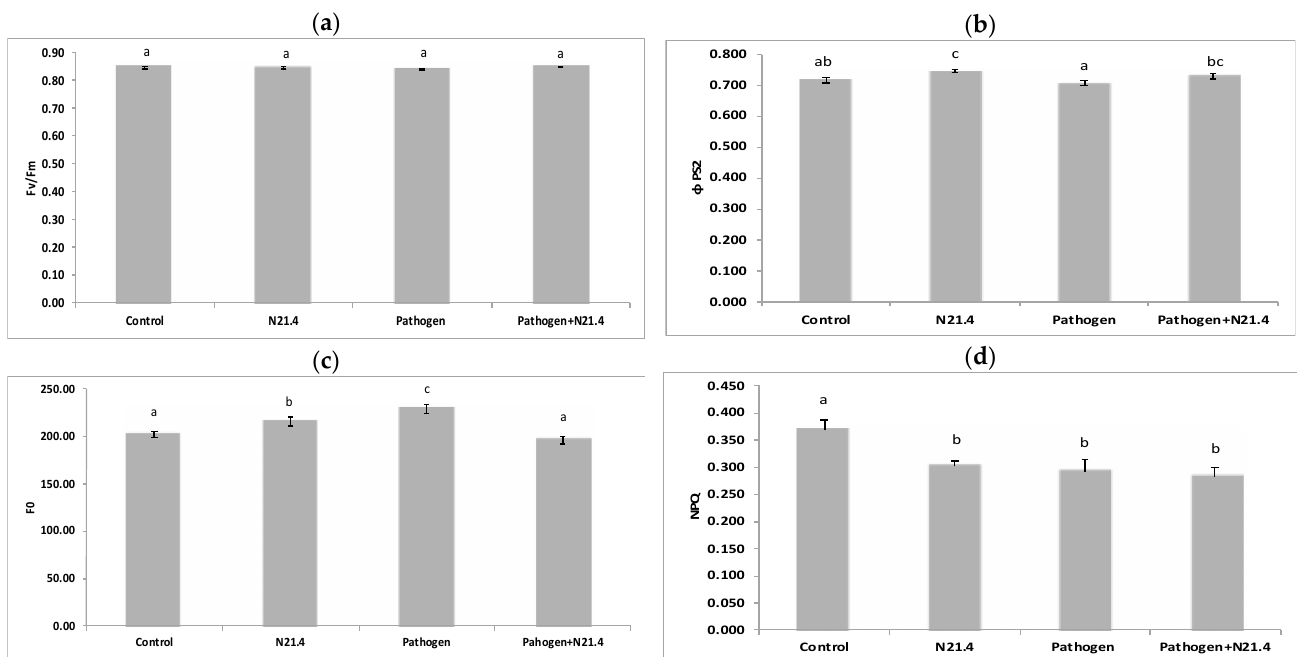
Figure 3. Photosynthesis parameters of 6-week old tomato plants inoculated with P. fluorescens N21.4 and non-inoculated controls in the priming phase and in the post-challenged priming state after inoculation with the leaf spot pathogen Xanthomonas campestris . ( a ) Fv/Fm (maximum quantum yield). ( b ) Φ PSII: photochemical quenching (efficiency of Photosystem II). ( c ) Fo (Minimum fluorescence). ( d ) NPQ (Non-photochemical quenching). These parameters were measured under ambient light conditions, after 1 h dark-adaptation. Control: Non treated or challenged plants. N21.4: plants treated with Pseudomonas fluorescens. Pathogen: plants challenged with the leaf spot pathogen Xanthomonas campestris . Pathogen + N21.4: plants treated with Pseudomonas fluorescens N21.4 and challenged with the leaf spot pathogen Xanthomonas campestris. Bars indicate standard errors ( n = 12). Different letters indicate significant differences ( p < 0.05).